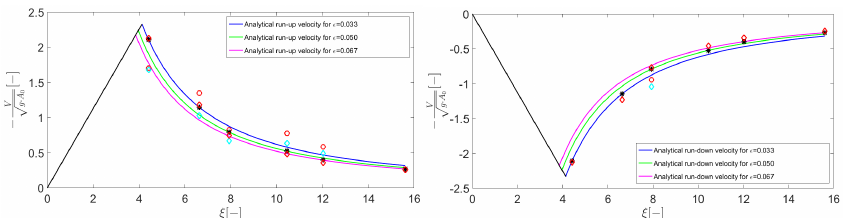
Figure 10. Maximum shoreline velocities during run-up ( left ) and run-down ( right ). Analytical (black stars), experimental (red circles) and numerical (diamonds)—with experimental (cyan) and analytical (red) boundary condition. Solid black line according to Equation (7). Colored solid lines are computed according to Equation